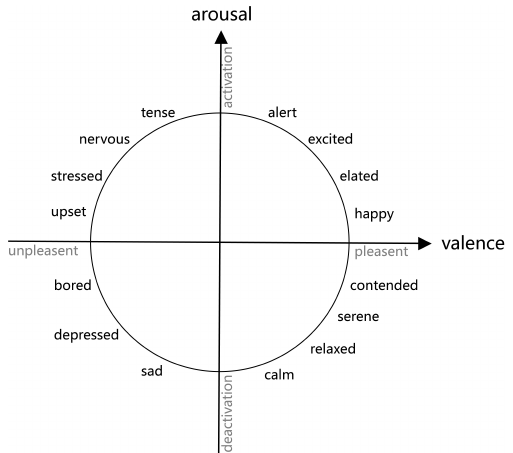
Figure 2. Valence and arousal model proposed by